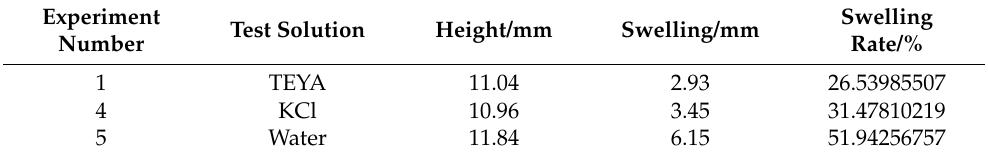
Table 1. Linear swelling tests of